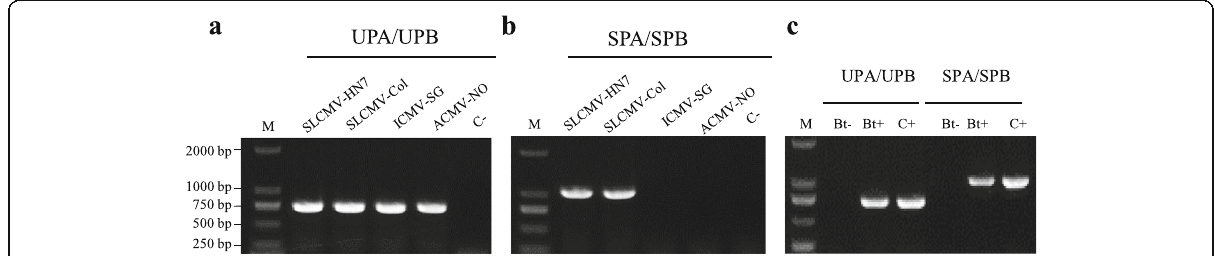
Fig. 1 Optimization of PCR to detect Cassava mosaic virus (CMV) from plants and Q-biotype Bemisia tabaci (Mediterranean, MED) . Agarose gel electrophoresis analyzed PCR products amplified from multiple CMVs including Sri Lankan cassava mosaic virus (SLCMV), Indian cassava mosaic virus (ICMV), and African cassava mosaic virus (ACMV) with primer pairs UPA/UPB ( a ) and SPA/SPB ( b ). C – , healthy plant. c DNA gel electrophoresis of PCR products amplified from SLCMV-Col viruliferous Bemisia tabaci with primer pairs UPA/UPB and SPA/SPB. Bt – , non-viruliferous Bemisia tabaci ; Bt+, SLCMV-Col viruliferous Bemisia tabaci ; C+, positive control of SLCMV-Col infected plants; M, DNA marker